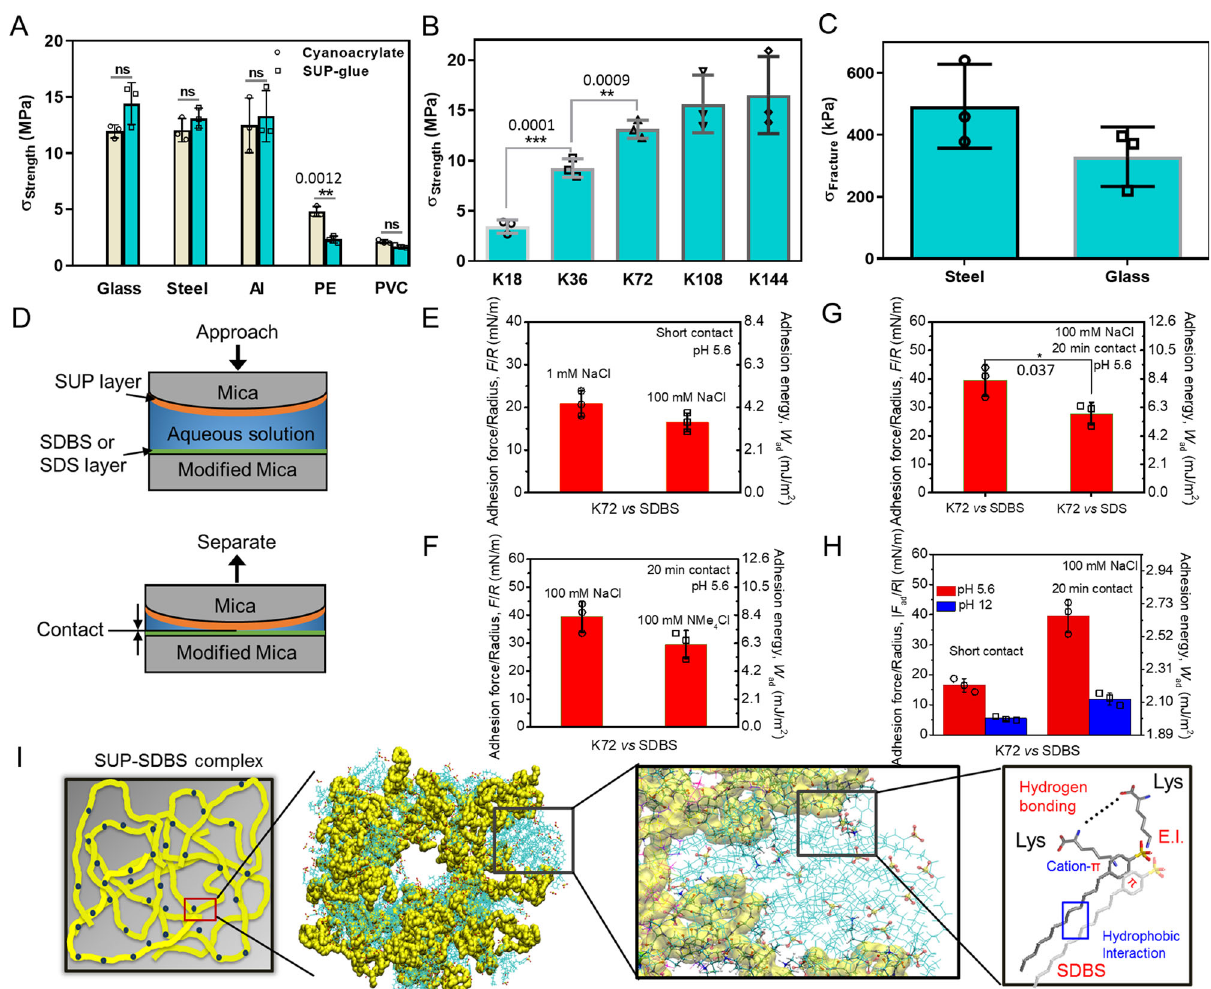
Fig. 2 Bulk adhesion behavior of the SUP glues. A Illustration of lap shear testing for the K72-SDBS glue and fracture strengths in comparison to commercial cyanoacrylate-based glue on glass, steel, aluminum, polyethylene (PE), and polyvinyl chloride (PVC). ns, no signi fi cant difference. ** p < 0.01. B Correlation of bulk adhesion strength measured on steel substrate with SUP molar masses starting from K18 and ranging to K144. ** p < 0.01; *** p < 0.001. C SUP glue lap shear testing in an aqueous environment. Two sets of measurements were performed on steel and glass, respectively. D Schematic of surface force apparatus (SFA) measurement. Two opposing curved mica surfaces with radius R in crossed-cylinder con fi guration coated with a K72 layer and an SDBS (or a sodium dodecyl sulfate (SDS)) layer, respectively, were fi rst approached to each other until they come into contact, and were then separated to measure the adhesion force ( F ad ). E Impact of aqueous conditions on the adhesion between K72 and SDBS layers as revealed by SFA measurements. 1 m M NaCl vs. 100 m M NaCl (pH 5.6 and short contact); F 100 m M NaCl vs. 100 m M NMe 4 Cl (pH 5.6 and 20 min contact); G Adhesion comparison between K72 and SDBS layers, and between K72 and SDS layers in 100 m M NaCl at pH 5.6. * p < 0.05. H pH 5.6 vs. pH 12 (100 m M NaCl and 20 min contact). The short contact refers to a contact time of 1 min. I Proposed molecular mechanism for the strongly adhesive SUP-SDBS complexes. The simulated structure of the K18-SDBS complex is presented in yellow and cyan, respectively. Different interactions govern the adhesive and cohesive strength including electrostatic interactions (E.I.), cation- π interactions, van der Waals forces, hydrogen bonds, hydrophobic interactions, and other aromatic interactions. All presented data are mean values± SD from the mean from N = 3 independent measurements on independent samples. All p -values were calculated using two-sided Student ’ s t